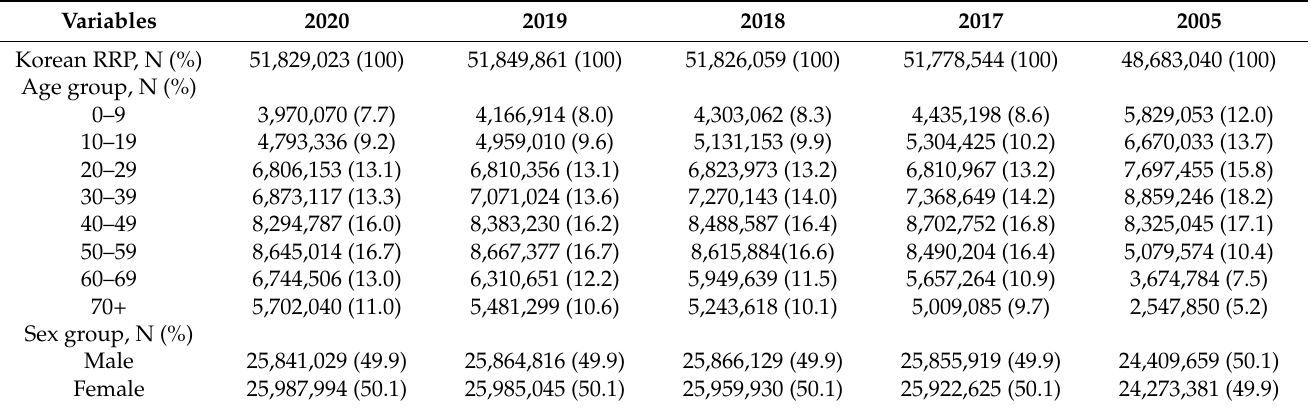
Table 1. Korean RRP structure by age and sex from 2017 to 2020 and in